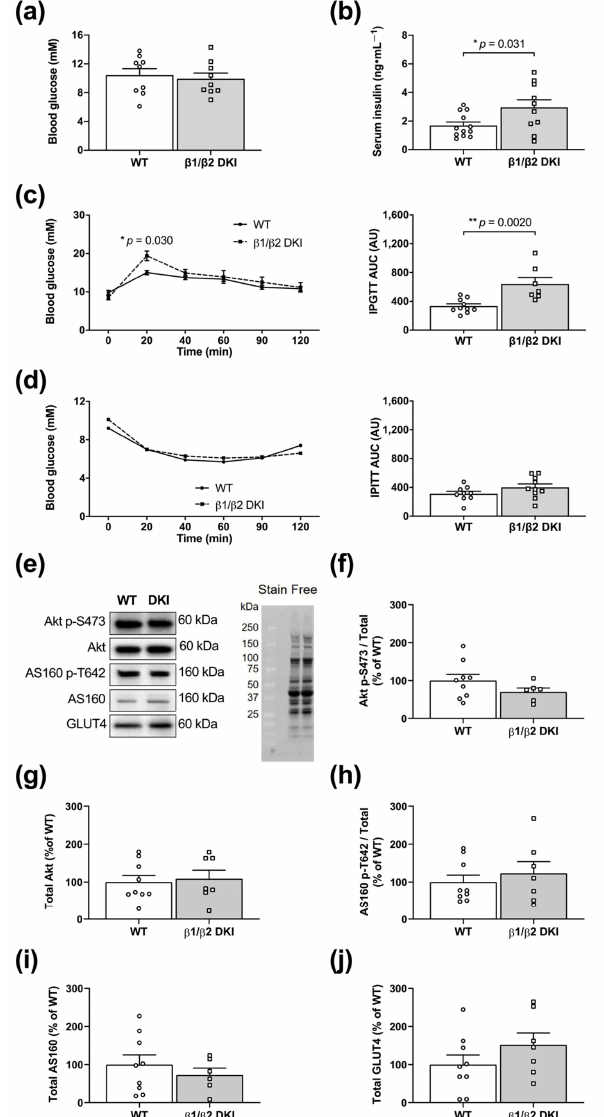
Figure 3. DKI mice are glucose intolerant but maintain whole-body insulin sensitivity. ( a ) Blood glucose was assessed via tail tip bleed in male DKI and WT mice following a 6 h fast. Male mice, n = 9, 17–20 wk. ( b ) Blood was collected via retro-orbital bleed from DKI and WT mice following a 6 h fast, and serum samples were analyzed for insulin concentration. Male mice, n = 10–12, 20–27 wk. ( c and inset ) Following a 6 h fast, DKI and WT mice were injected intraperitoneally with glucose (1 g · kg − 1 total lean mass), and blood glucose responses were measured over 2 h post-injection and area under the curve (AUC), with baseline as the mean blood glucose at time 0 for each genotype, was calculated to assess glucose handling. Male mice, n = 7–10, 17–20 wk. ( d and inset ) Following a 4 h fast, DKI and WT mice were injected intraperitoneally with insulin (0.5 units · kg − 1 total body mass), and blood glucose responses were measured over 2 h and AUC was calculated. Male mice, n = 9–10, 17–20 wk. Skeletal muscle was collected from male DKI and WT mice in the fed state, and phosphorylation status and total content of proteins associated with skeletal muscle glucose transport were quantified. ( e ) Representative immunoblots and stain-free image and quantified results of ( f ) Akt p-S573, ( g ) total Akt, ( h ) AS160 p-T642, ( i ) total AS160, and ( j ) total GLUT4 content in DKI versus WT skeletal muscle. Protein quantification was performed by normalizing the band intensity of the protein of interest to total lane protein using stain-free imaging, and phosphorylation was expressed relative to respective total protein content. Fed male mice, n = 7–9, 20–32 wk. * p < 0.05, ** p <